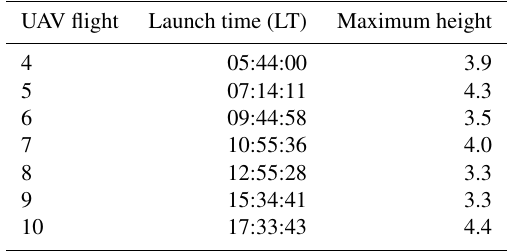
Table 2. Brief description of the UAV flights (7 June 2015). UAV